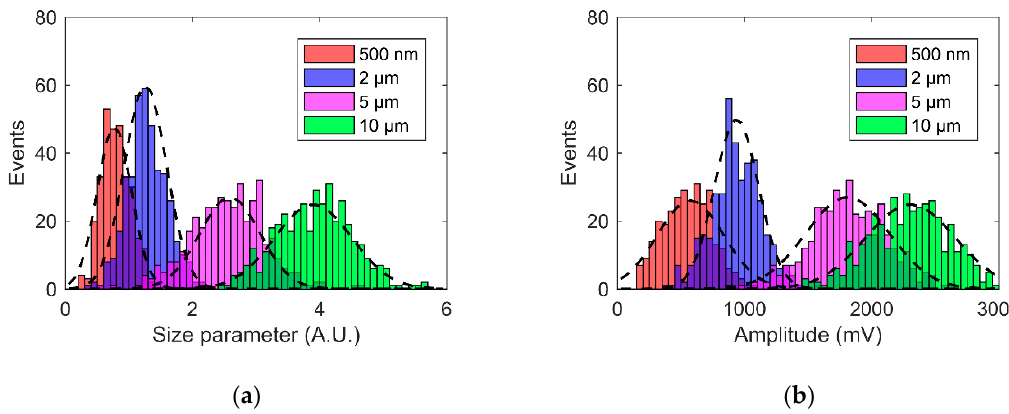
Figure 7. Correlation dot pilot of the PS beads detection. with different particle diameters: 500 nm (red); 2 μ m (blue); 5 μ m (pink); 10 μ m (green).